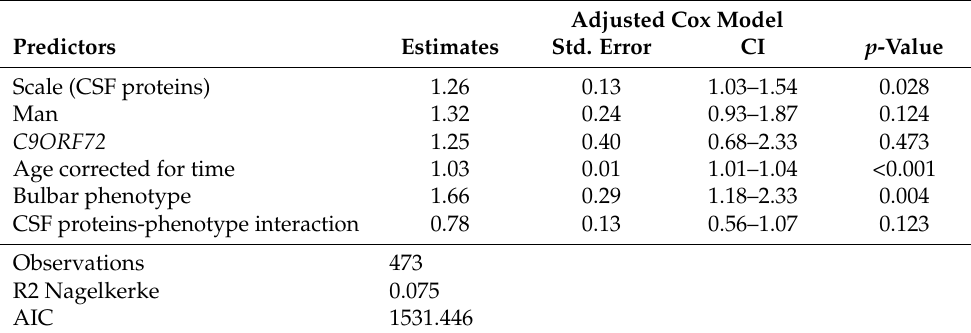
Table 6. Adjusted Cox model according to CSF protein values. In this model that is adjusted for the interaction with the phenotype, the HR of the interaction is 0.78. Therefore, for patients with the bulbar phenotype, the HR of CSF protein is 0.98 (95% CI 0.58 to 1.65) while for those with the spinal phenotype, it is 1.26. This means that—given a subject alive at a determined time for whom we increase the CSF protein value by one SD with respect to the mean (0.15 with respect to 0.41)—if the patient has a spinal phenotype, the increase will mean an increase in the risk of death of 25.66%. However, when the patient is of the bulbar phenotype, we do not observe a statistically significant effect. Age corrected for time refers to the time elapsed between onset and